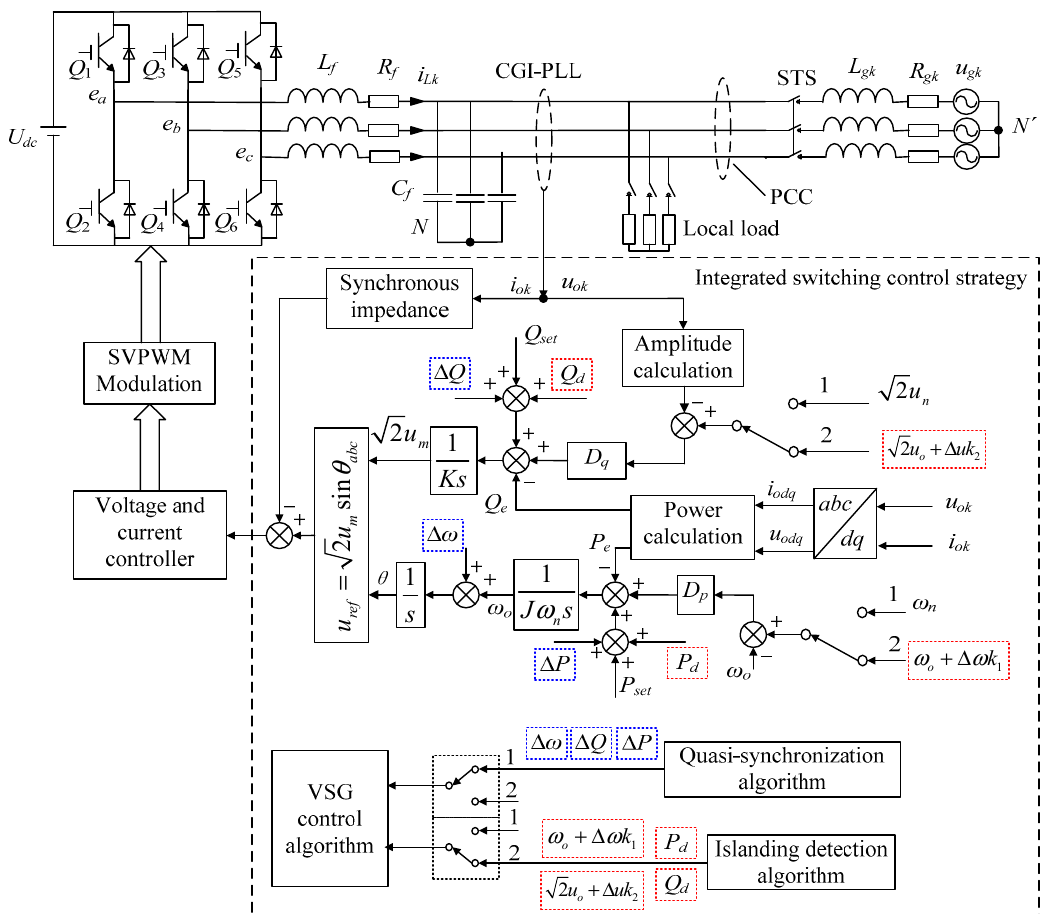
Figure 3. Block diagram of integrated switching control strategy.